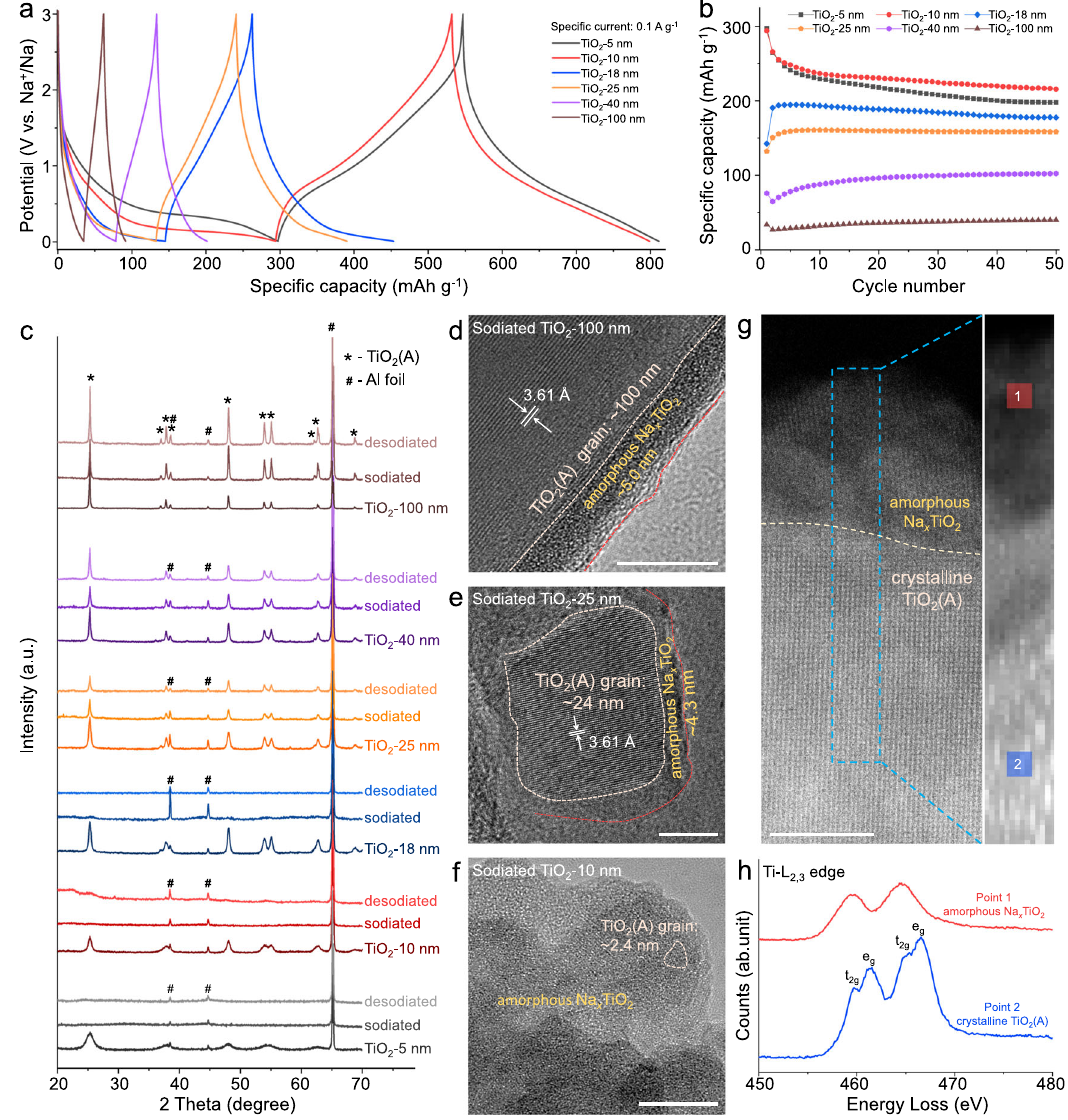
Fig. 1 | Structure and charge storage properties of various TiO 2 (A) NPs. The initialsodiationand desodiation curves( a ) and cycling performance at0.1Ag − 1 ( b ) of different TiO 2 NPs, respectively. c Ex-situ XRD patterns of different TiO 2 NPs. Below 18nm the (de)sodiated NPs are X-ray amorphous, whereas larger ones (>18nm) remain crystalline. The ex-situ HRTEM images of TiO 2 -100nm ( d ),